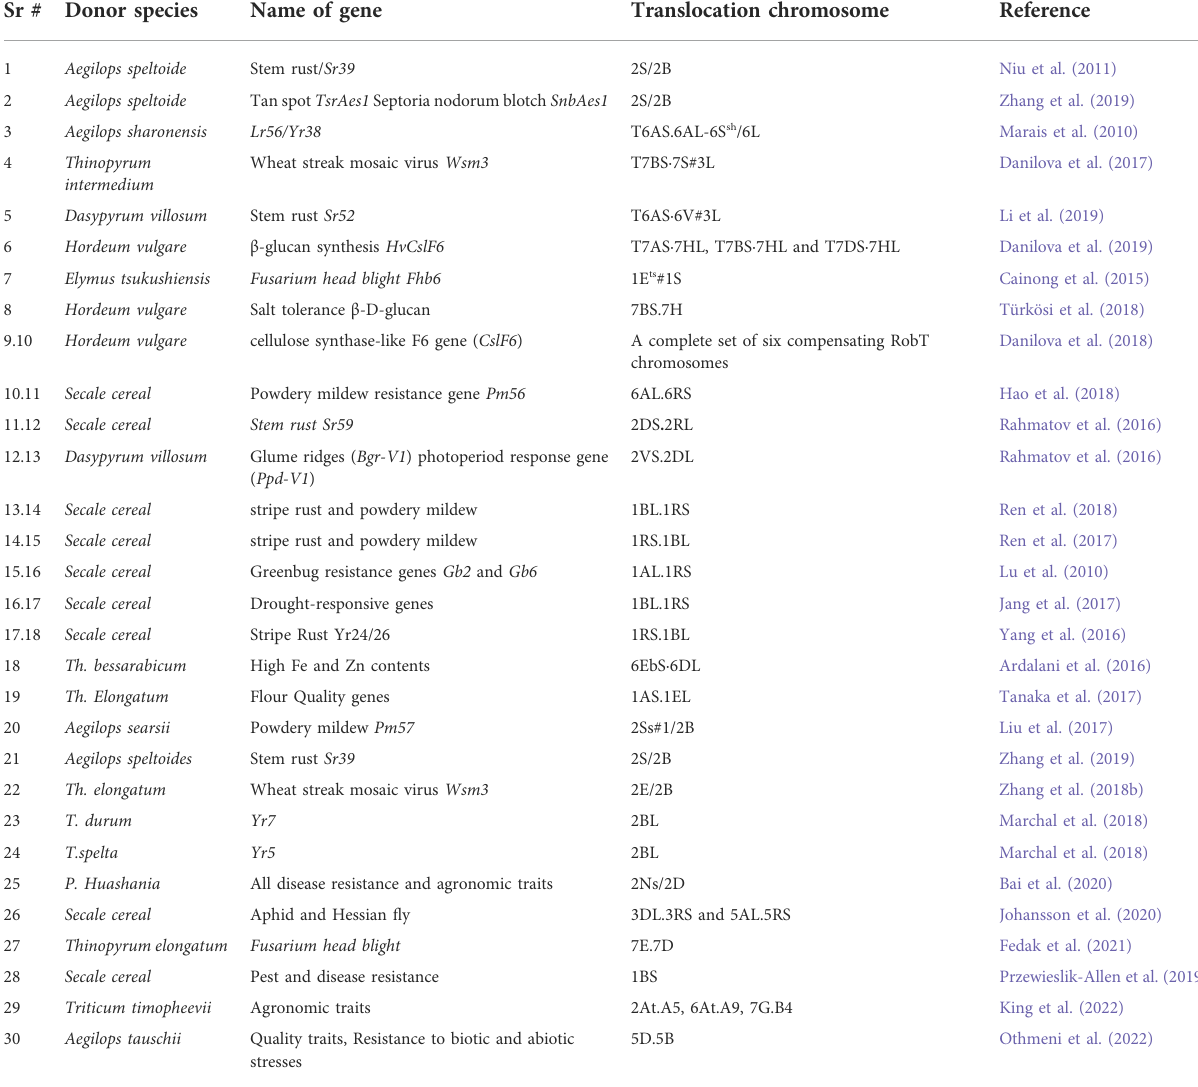
TABLE 1 List of genes/translocations successfully transferred from wild relatives into